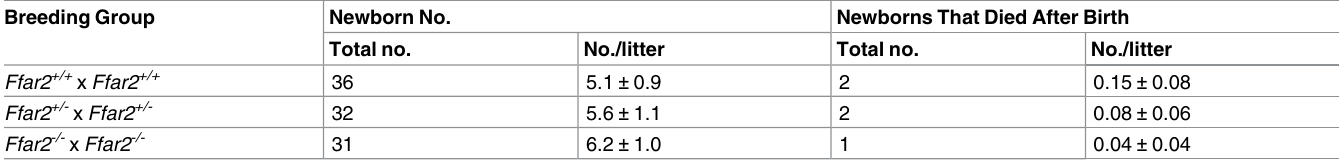
Table 1. Litter size and morbidity rate Breeding